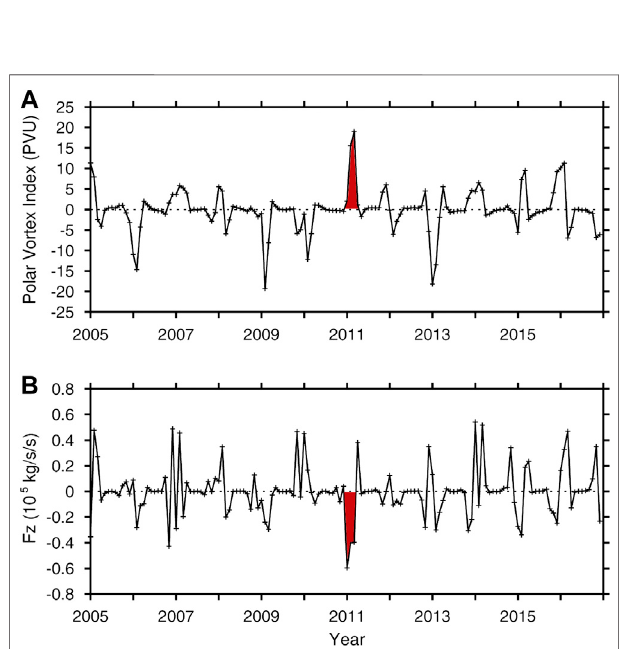
FIGURE 5 | Variations in (A) the northern polar vortex index (units: PVU) and (B) the vertical component of EP fl uxes ( Fz : averaged from 45 to 75 ° N at 50 hPa) (units: 10 5 kg/s/s) from 2005 to